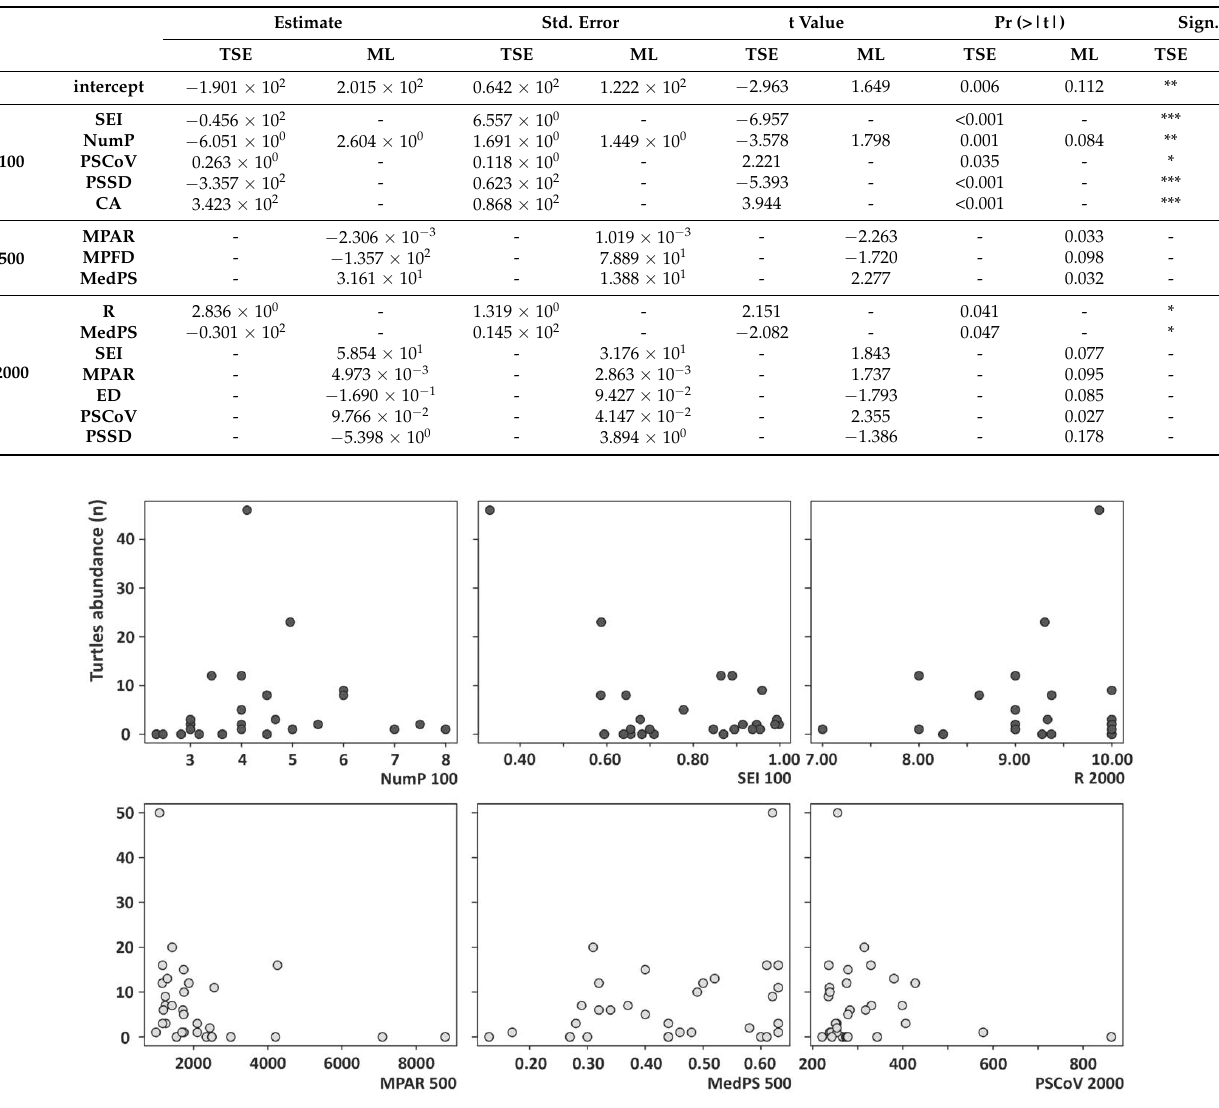
Figure 6. Abundance of M. leprosa (pale gray) and T. s. elegans (dark gray) along the main landscape variables (i.e., those showing statistically significant relationships with the species distribution). NumP: number of patches; SEI: Shannon’s evenness index; R: richness; MPAR: mean perimeter–area ratio; MedPS: median patch size; PSCoV: patch size coefficient of variance.